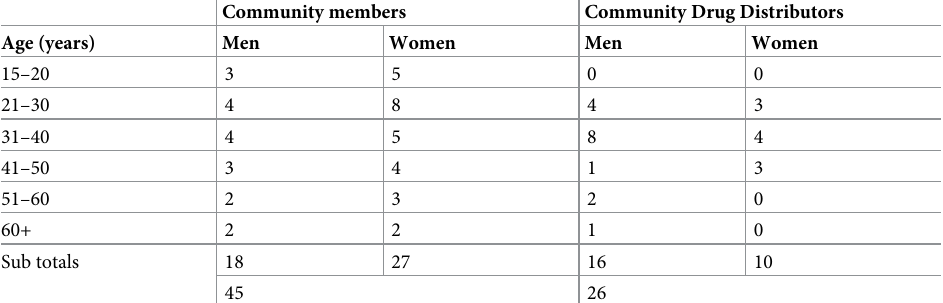
Table 1. Summary of